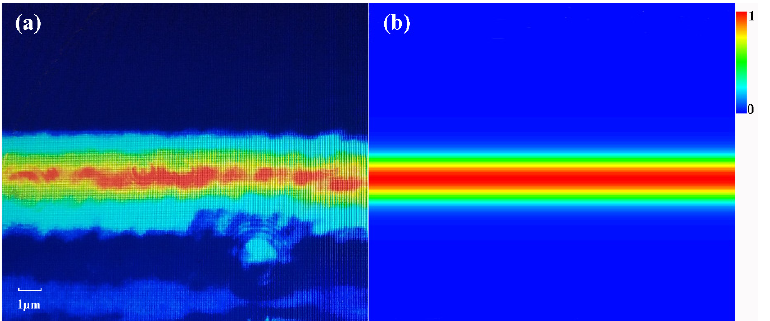
Figure 3. The near-field optical intensity profile of the waveguide irradiated with fluence of 1.5 × 10 15 ions/cm 2 : ( a ) experimental result collected by CCD camera; ( b ) simulation results by applying the beam propagation method.